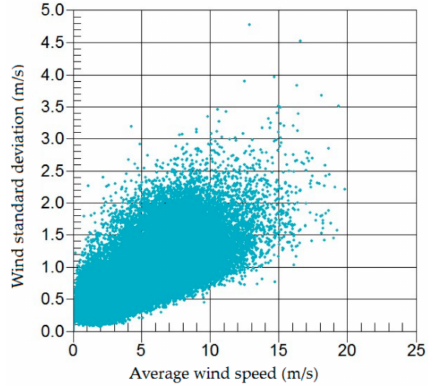
Figure 3. Standard deviation as a function of average wind speed at 10 m above ground